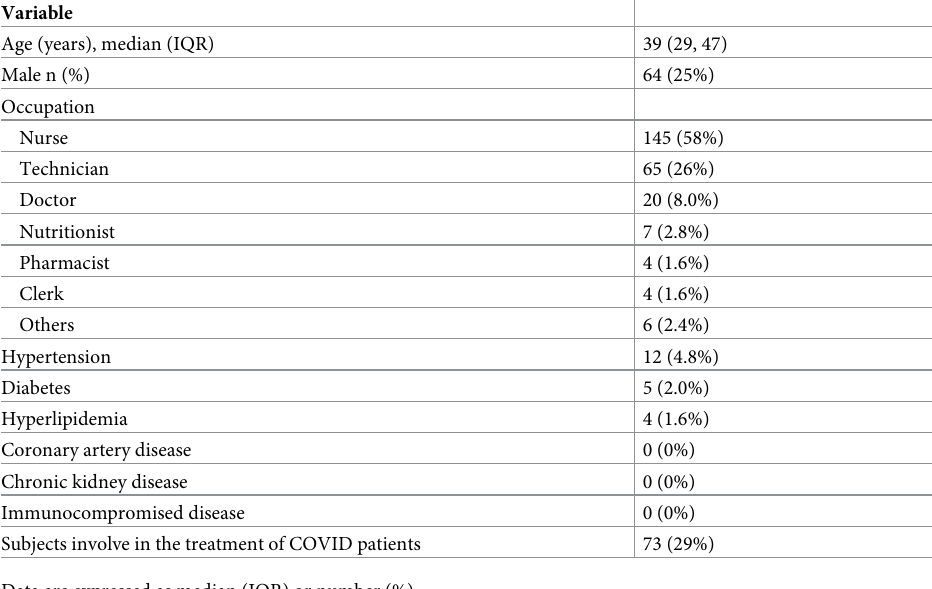
Table 1. Clinical characteristics in study